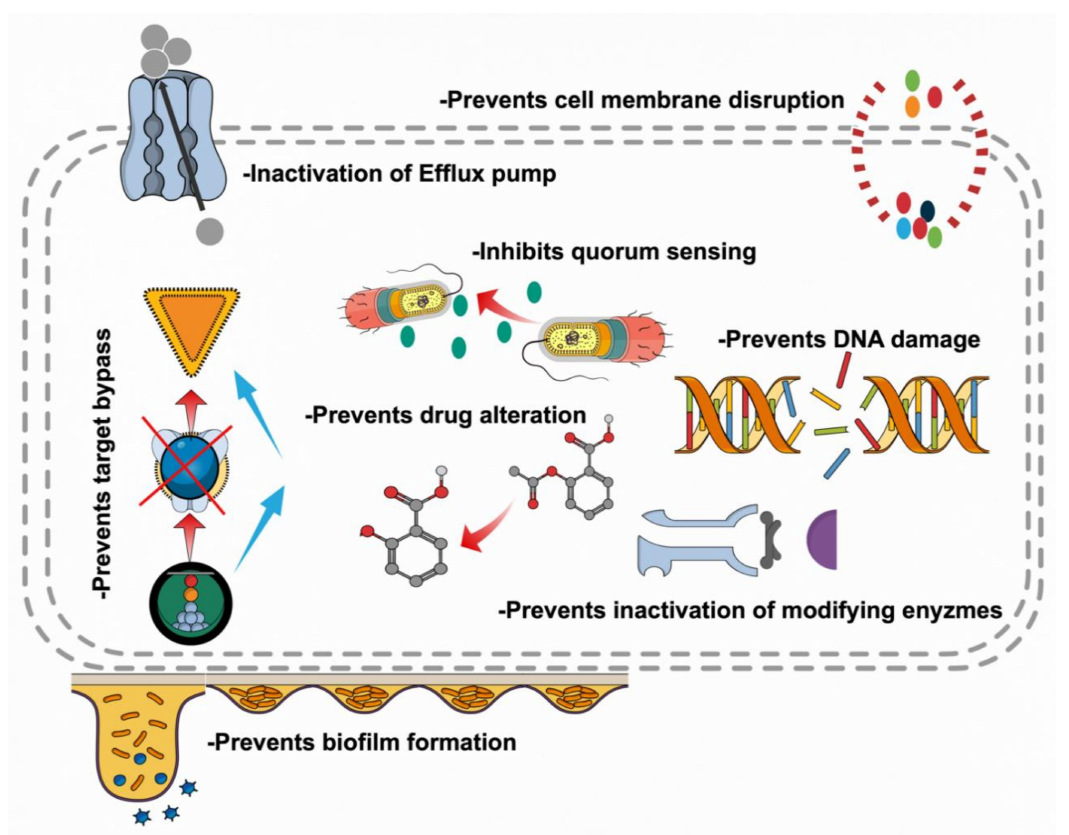
Figure 2. Phytochemicals as antimicrobials—mode of action and their e ff ectiveness against